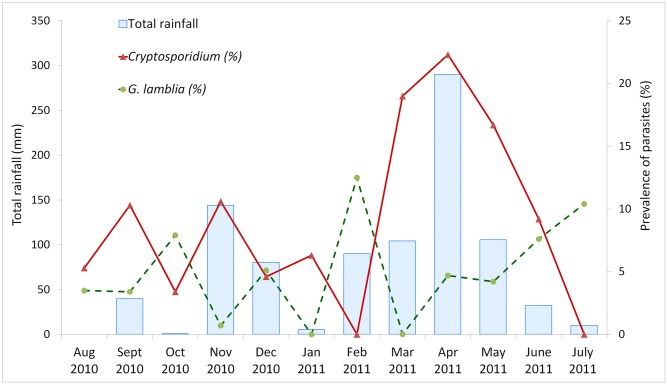
Prevalence of Cryptosporidium infection, G. lamblia infection and total rainfall each month during the study period.The graph shows the prevalence (%) of Cryptosporidium infection and G. lamblia infection among all study participants, together with the total rainfall in mm, for each month during the study period.